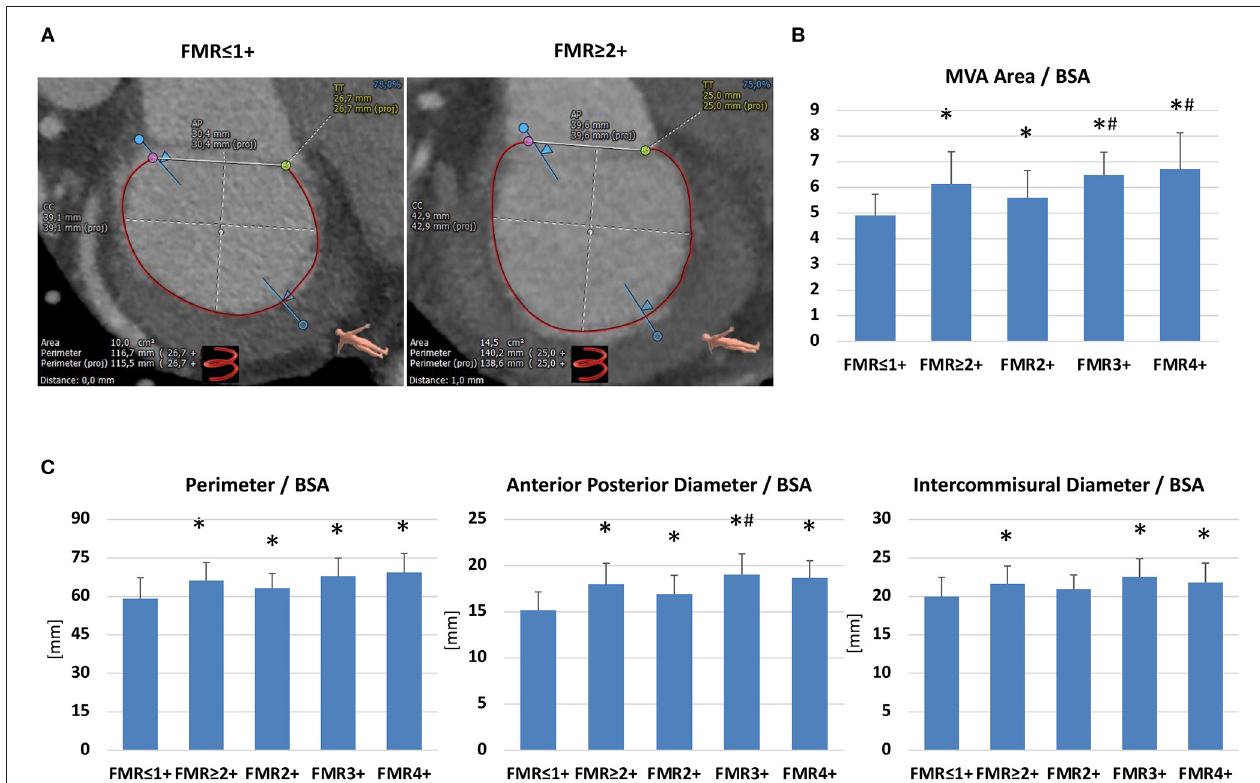
FIGURE 5 | Dimensions of mitral valve annulus dimensions in patients with or without functional mitral regurgitation. (A) MSCT-derived parameters of mitral valve annulus dimensions (CC, intercommisural diameter; AP, anterior-posterior diameter; TT, trigone-to-trigone diameter) in a patient with FMR ≤ 1 + and with FMR ≥ 2 + . (B,C) Mitral Valve Annulus (MVA) area, perimeter, anterior-posterior diameter and intercommisural diameter indexed to the Body Surface Area (BSA) in patients with FMR ≤ 1 + ( n = 145) compared to FMR ≥ 2 + ( n = 70) and the FMR subgroups (FMR2 + : n = 33, FMR3 + : n = 24, FMR 4 + : n = 13). * p < 0.05 compared to FMR ≤ 1 + ; # p < 0.05 compared to FMR2 +